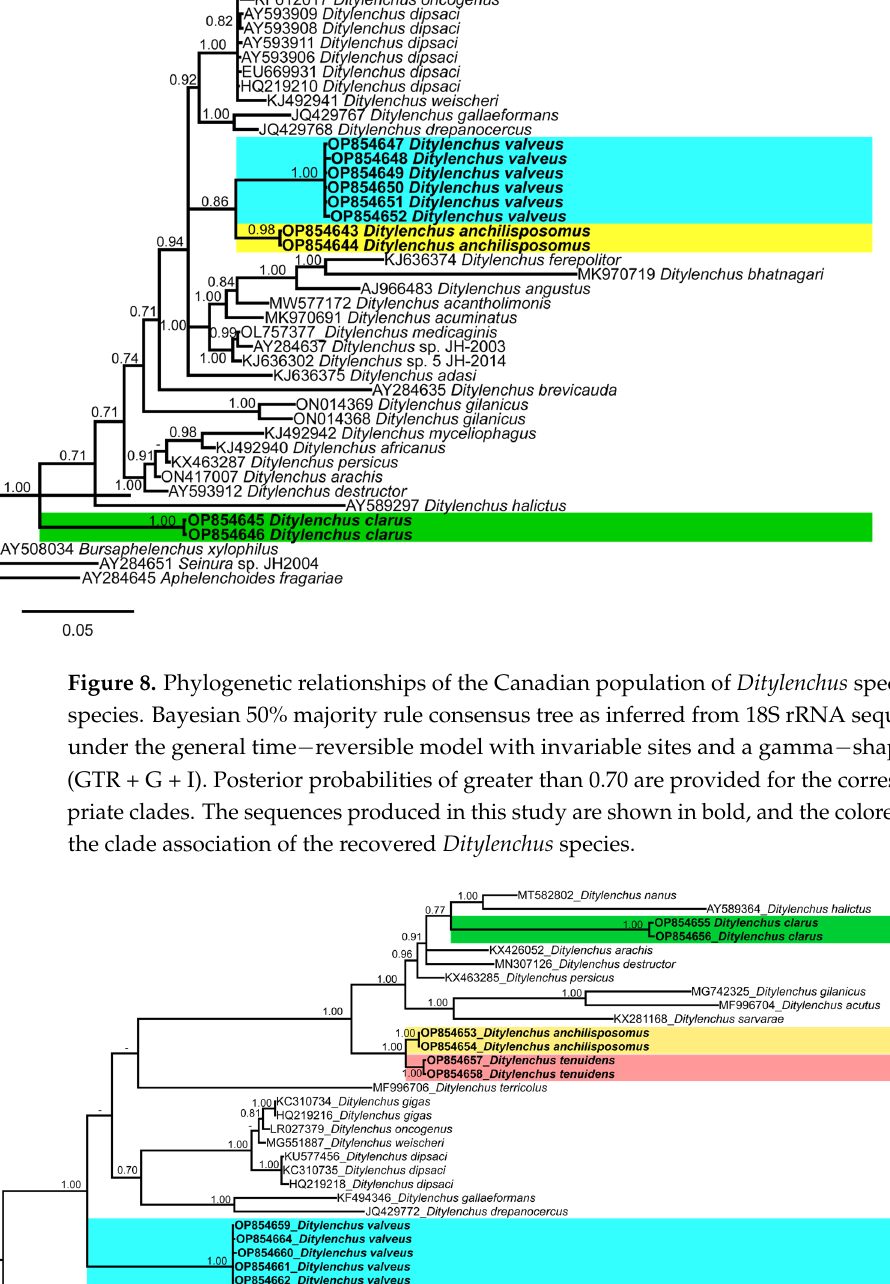
Figure 9. Phylogenetic relationships of the Canadian population of Ditylenchus species with related species. Bayesian 50% majority rule consensus tree as inferred from 28S rRNA sequence alignment under the general time − reversible model with invariable sites and a gamma − shaped distribution (GTR + G + I). Posterior probabilities of greater than 0.70 are provided for the corresponding clades. The sequences produced in this study are shown in bold, and the colored boxes indicate the clade association of the recovered Ditylenchus species.